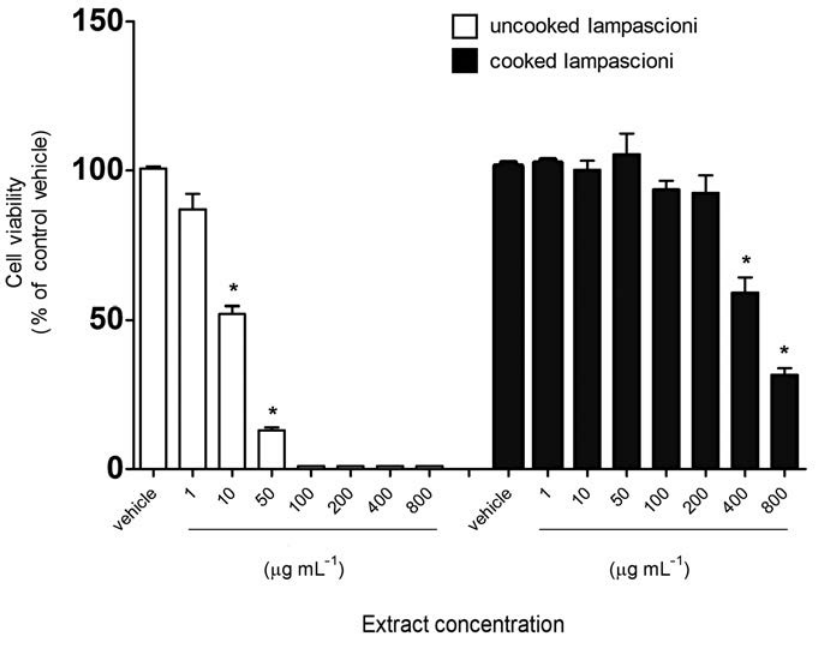
Figure 1. Cell viability of tumoral MCF-7 cells treated of extracts of raw and cooked (boiled) lampascioni ( Muscari comosum ). Asterisks indicate significantly difference at P<0.05, compared to the control